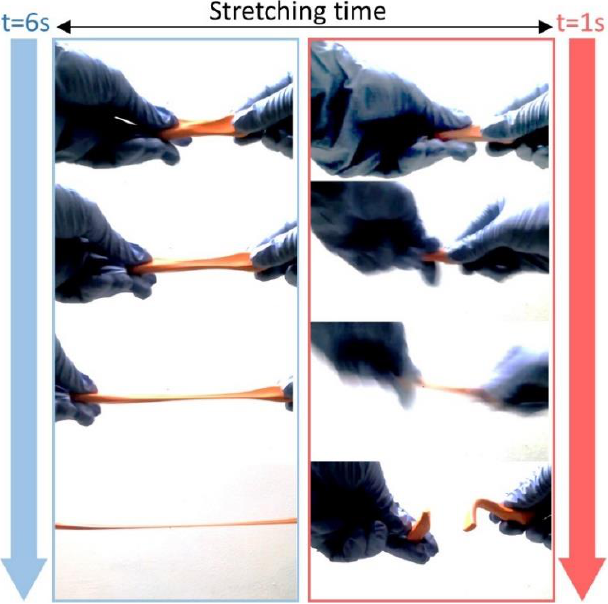
Figure 1. Effect of different strain rates on the diameter of the Silly Putty sample, a non-Newtonian Figure 1. E ff ect of di ff erent strain rates on the diameter of the Silly Putty sample, a non-Newtonian fluid.